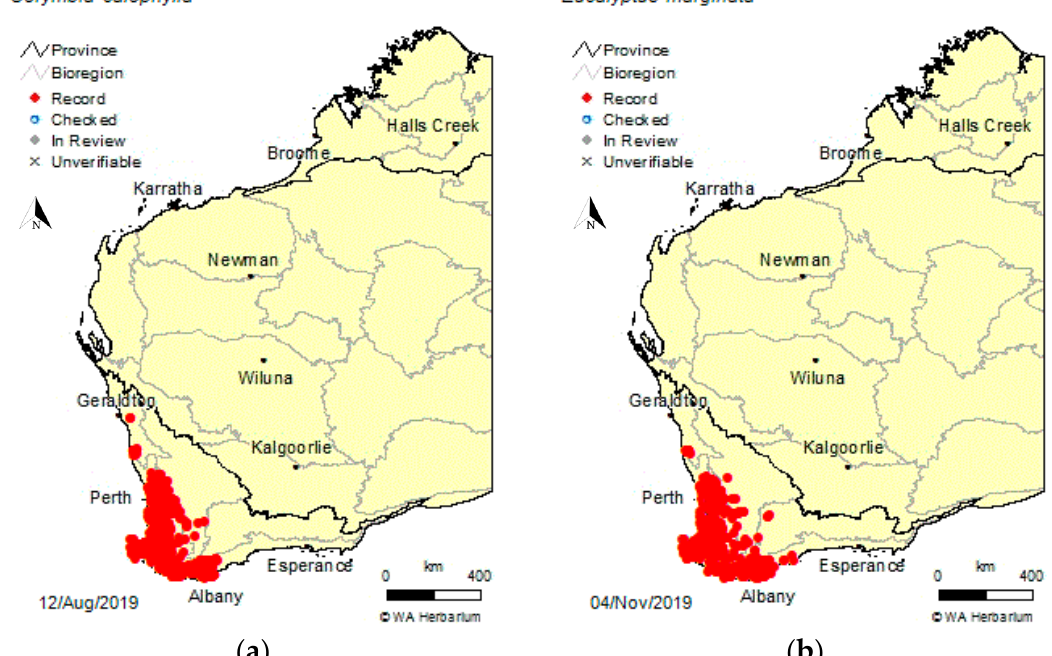
Figure 1. Geographic extent of Corymbia calophylla ( a ) and Eucalyptus marginata ( b ) [3].